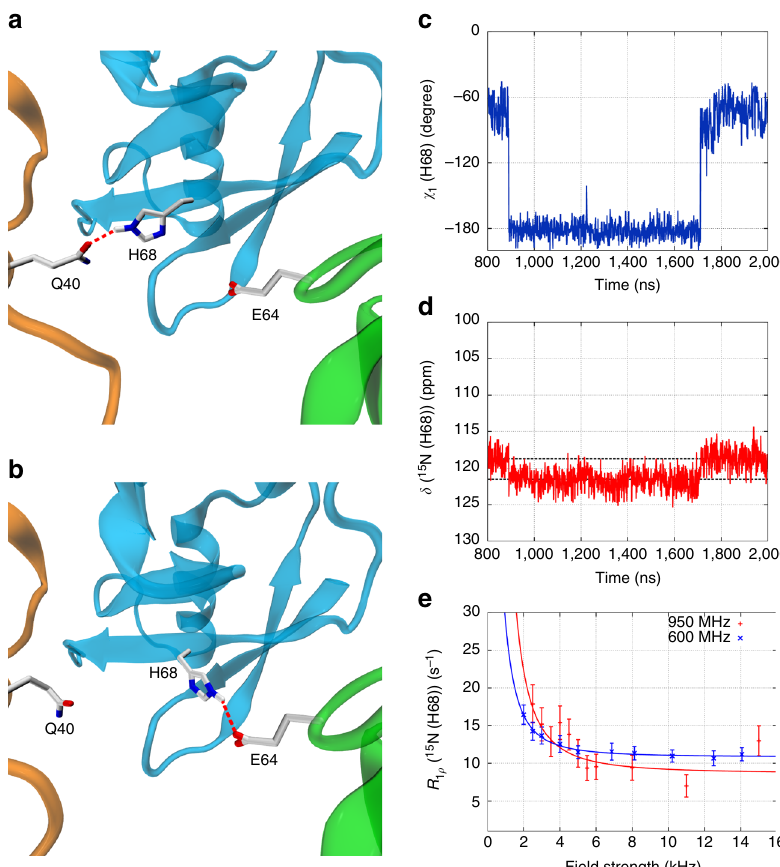
Fig. 6 Microsecond time scale dynamics of residue H68 (chain A) in cubic-PEG-ub crystals. a , b Intermolecular hydrogen bonds alternatively formed between H68 and Q40 or E64 as seen in the MD simulation of cubic-PEG-ub. c , d Time variation of side-chain torsional angle χ 1 ( t ) and main-chain 15 N chemical shift δ ( t ) for residue H68 in the selected ubiquitin molecule from the simulated unit crystal cell. e Experimental relaxation dispersion data for residue H68 (chain unassigned) in the cubic-PEG-ub crystal; also shown are the results of fi tting using fast exchange model ( continuous lines ). Error bars of R 1 ρ values were determined from Monte Carlo analysis. The motional time scale according to the experimental data, 56 μ s, is one-to-two orders of magnitude slower than suggested by the MD simulations (the same is true for other manifestations of μ s dynamics in ubiquitin crystals). The animated version of this graph is available as Supplementary Movie